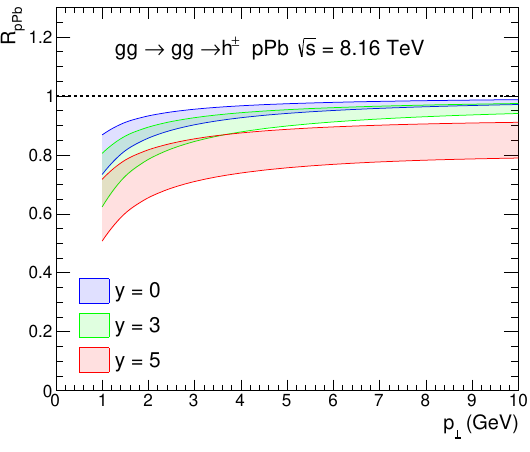
, eq. (3.14), at p = 2 GeV, in the gg ( gg ) channel pA R ? ! , eq. (3.13), is shown for (cid:22) (cid:24) = 1 = 2 (dashed black line). Right: R h as a pA pA . Calculations are done at ? gg channel. !